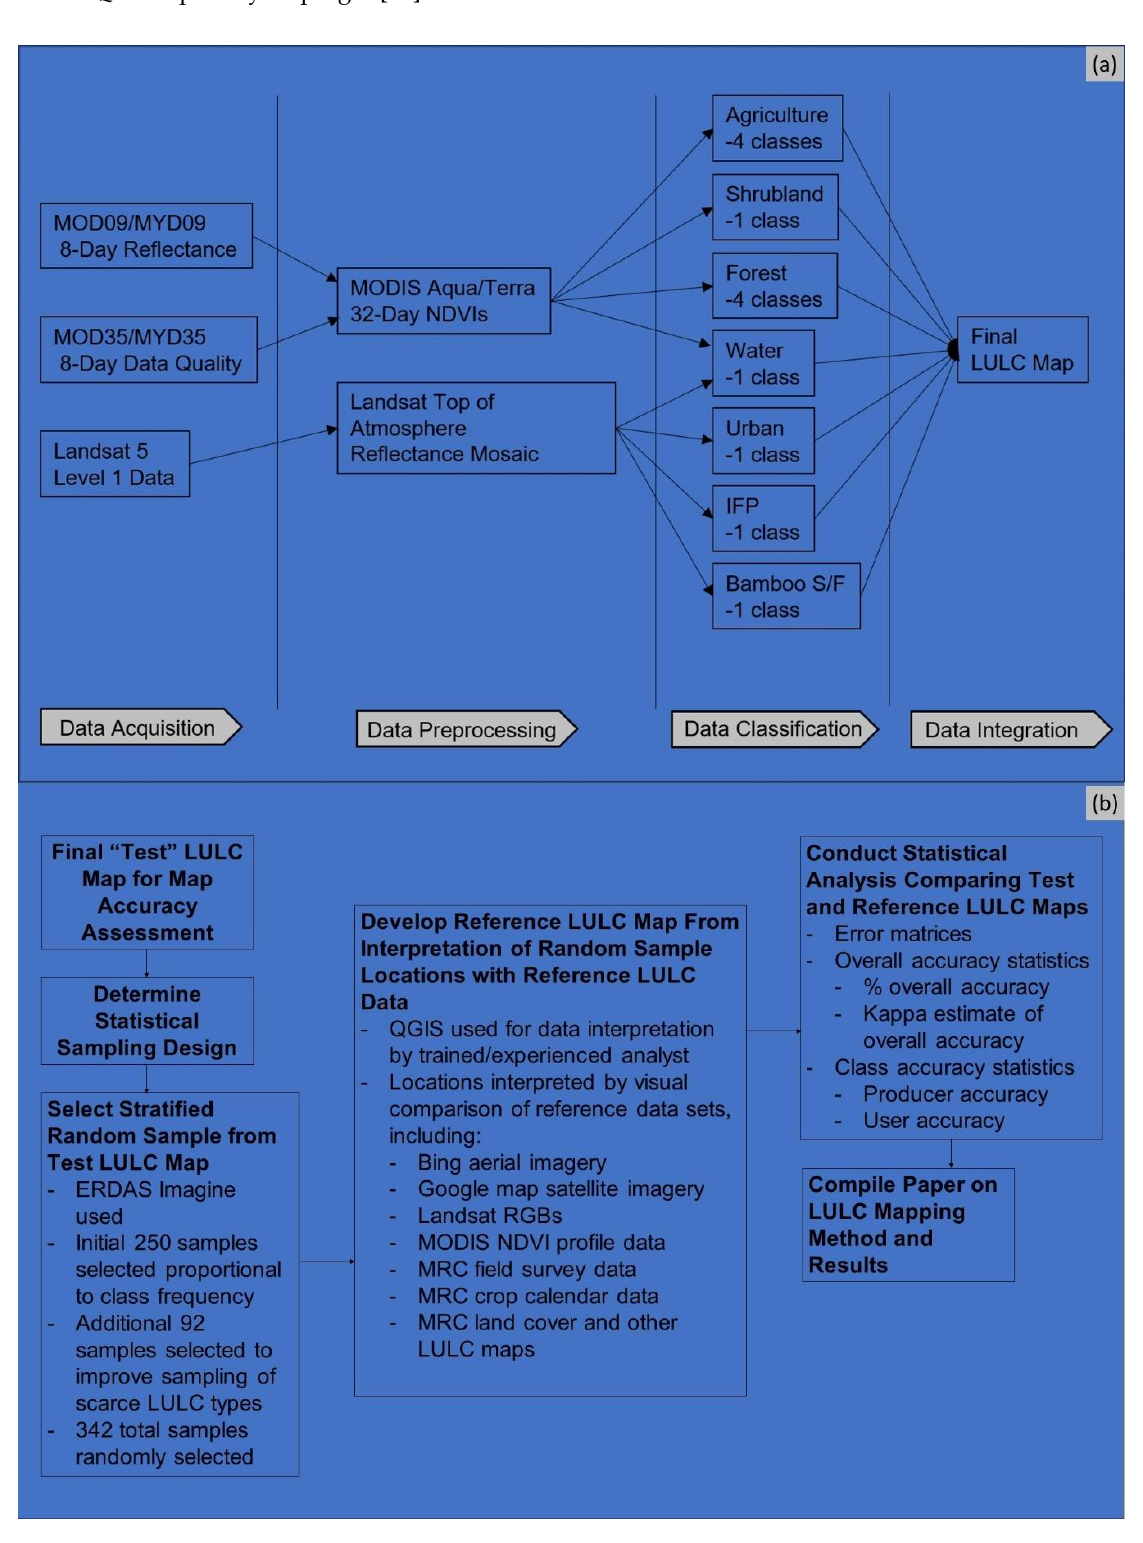
Figure 4. Generalized work flow for LULC mapping ( a ) and LULC map accuracy assessment ( b ) components of project. For acronyms in above graphic, IFP = Industrial Forest Plantation and S/F = Scrub/Forest.